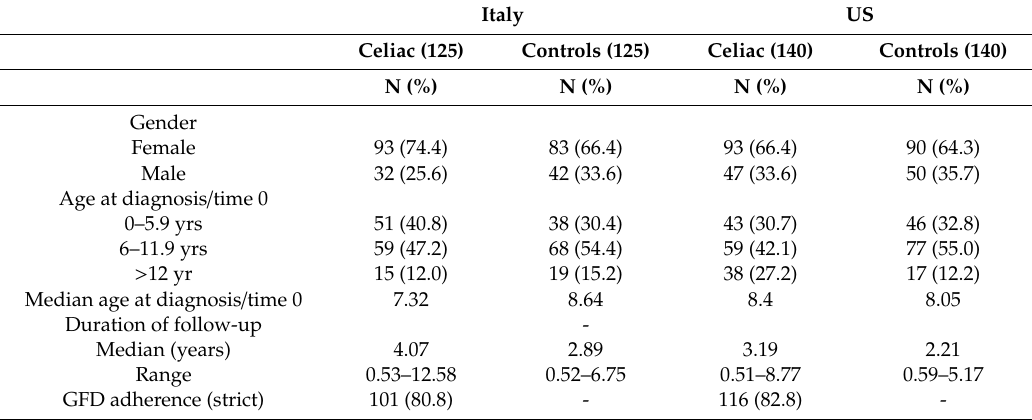
Table 1. Features of the enrolled